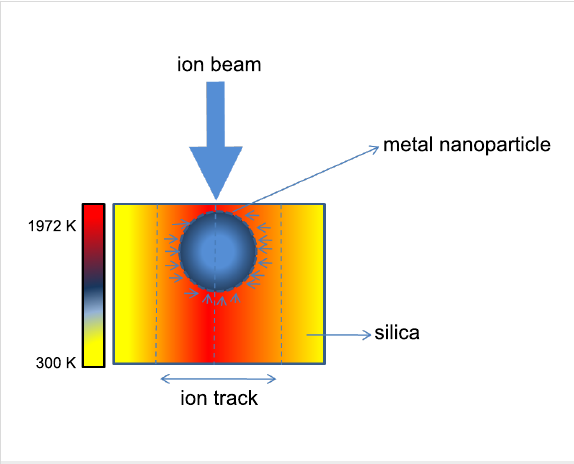
Figure 6: Schematic diagram of the formation of a thermal spike in the nanocomposite system. The small arrows around the metal nanopar- ticle correspond to the heat transferred to the nanoparticle from the surrounding molten